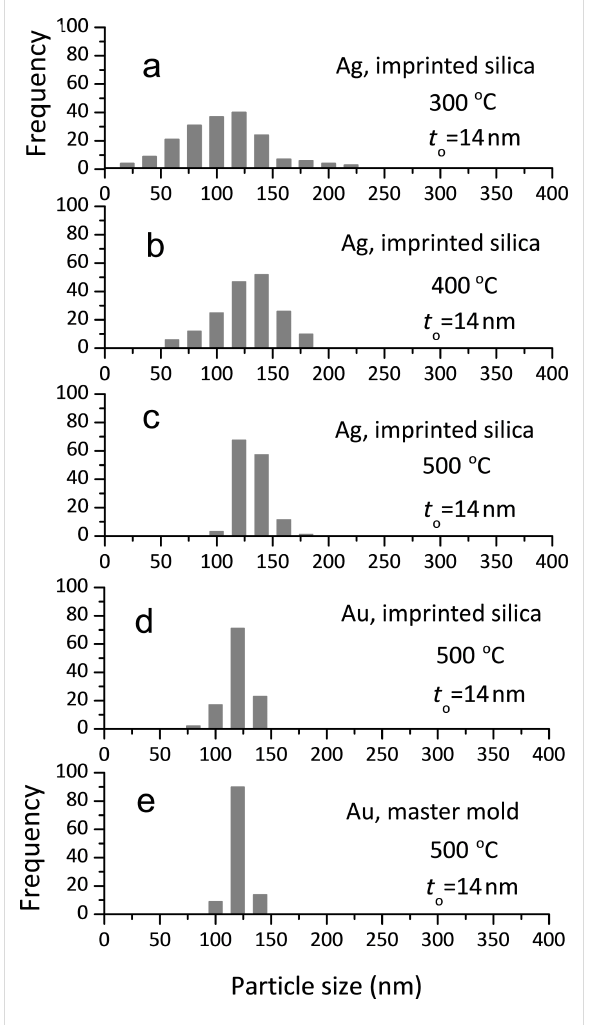
Figure 7: Size distribution of (a–c) Ag and (d) Au particles formed at different dewetting temperatures on imprinted sol–gel silica, and (e) Au particles formed on the silicon master